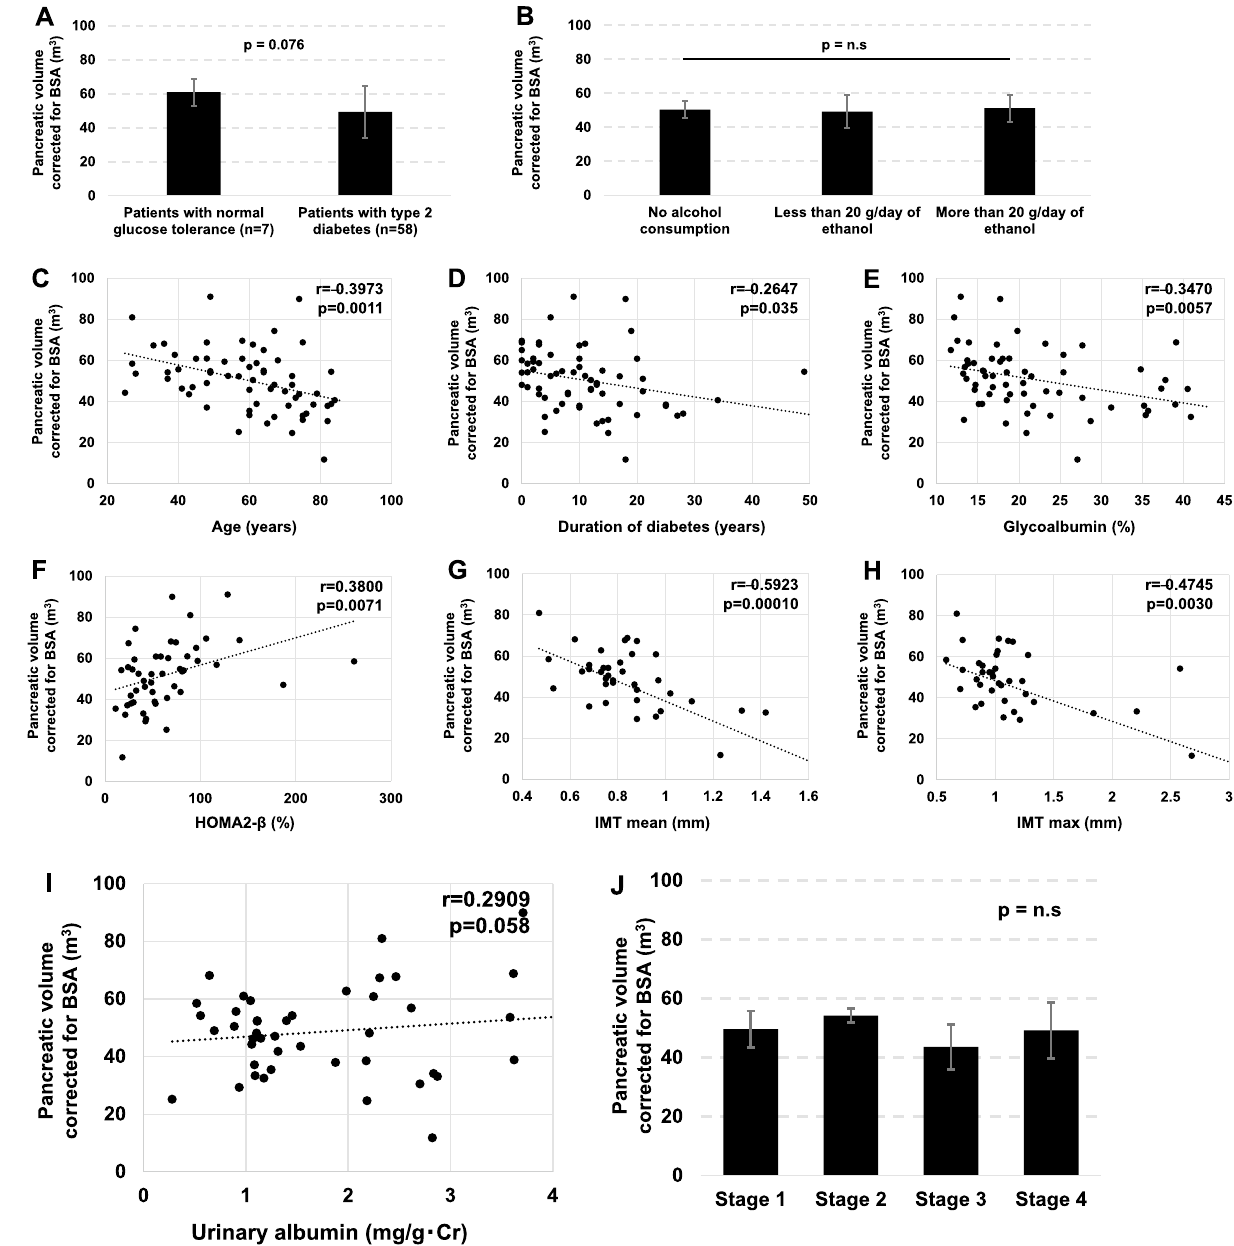
diabetes-related parameters. There was a negative correlation between BSA-corrected pancreatic volume and age, duration of diabetes, glycoalbumin, mean and max IMT, and there was a positive correlation between BSA- corrected pancreatic volume and